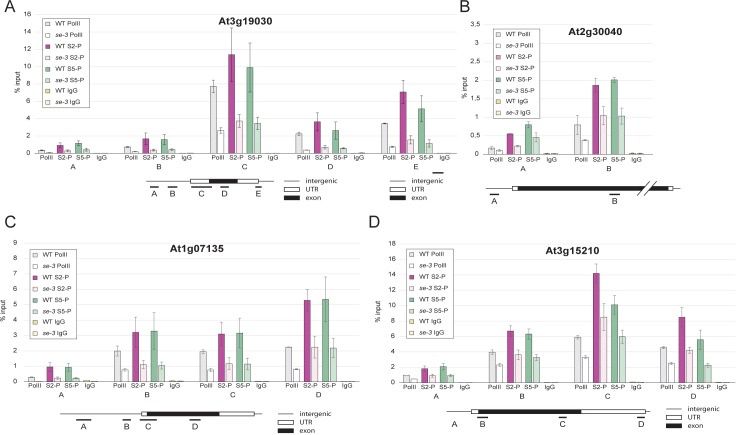
SE ensures efficient association of pol II CTD-Ser2P and pol II CTD-Ser5P to its target genes.(A–D) Analysis of pol II occupancy at SE target loci by pol II-ChIP qPCR in WT and se-3. General pol II CTD, pol II CTD-Ser2P and pol II CTD-Ser5P specific antibodies and mouse IgGs (as negative control) were used for immunoprecipitation. Error bars denote the range of two biological replicates.